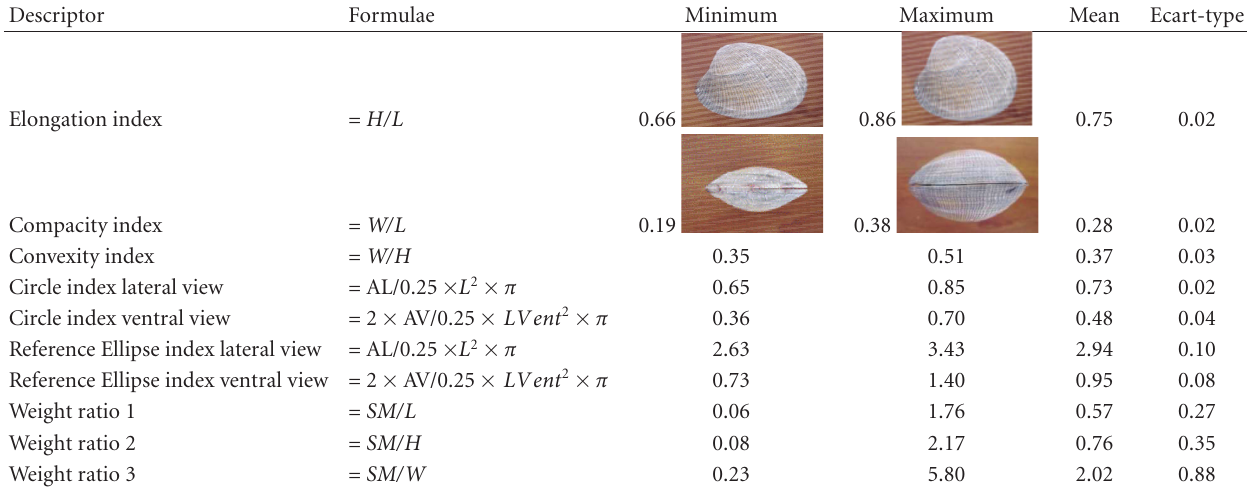
Table 1: Morphometric variables for arcachon